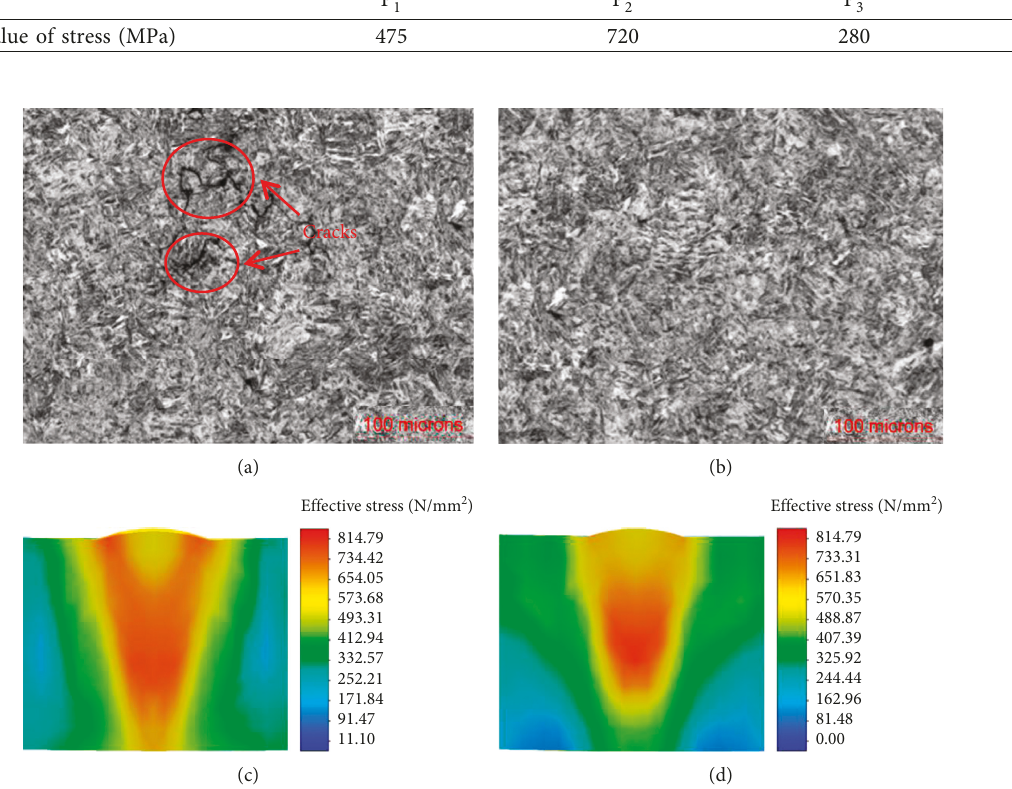
Figure 11: Comparison between the measured and the simulated results: the cross section of the weld bead under the (a) 1 st and (b) 2 nd welding conditions; the stress distributions under the (c) 1 st and (d) 2 nd welding between the temperature and material flow stress is shown in Figure 4. The residual stresses at the trace point P at dif- 2 ferent temperatures were extracted and compared to the material flow stress curve.